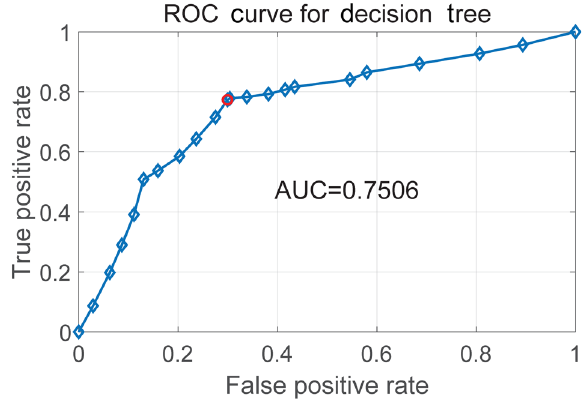
Fig. 3 ROC curve of the optimized decision tree. The blue line represents the pair of true positive rate against false positive rate and AUC value denotes the area under the ROC curve.